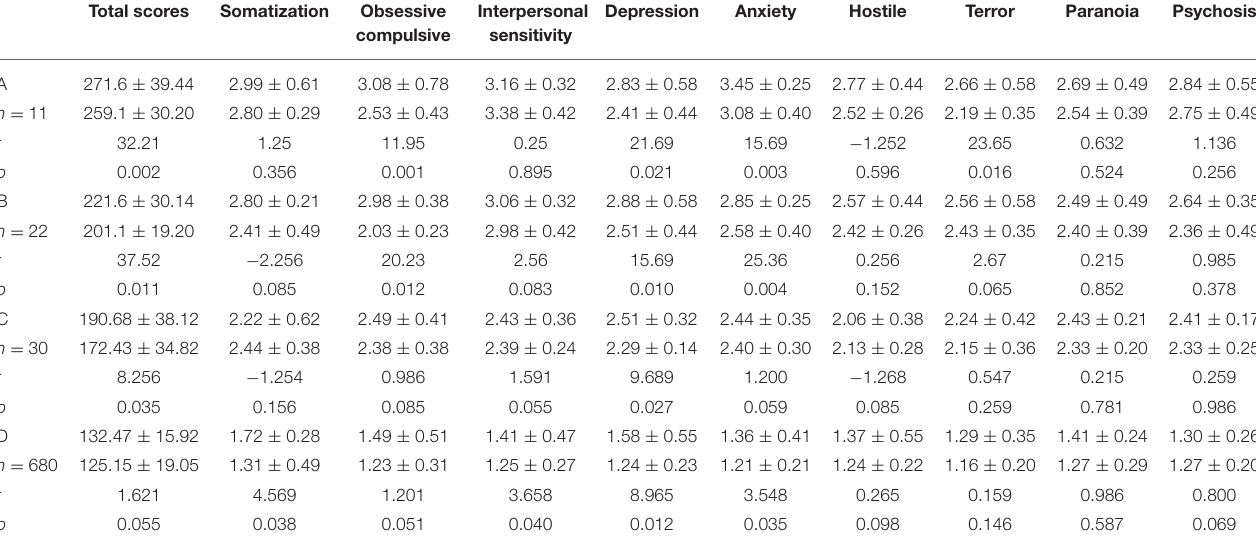
TABLE 6 | Comparison of M ± SD scores of employees in different positions after the